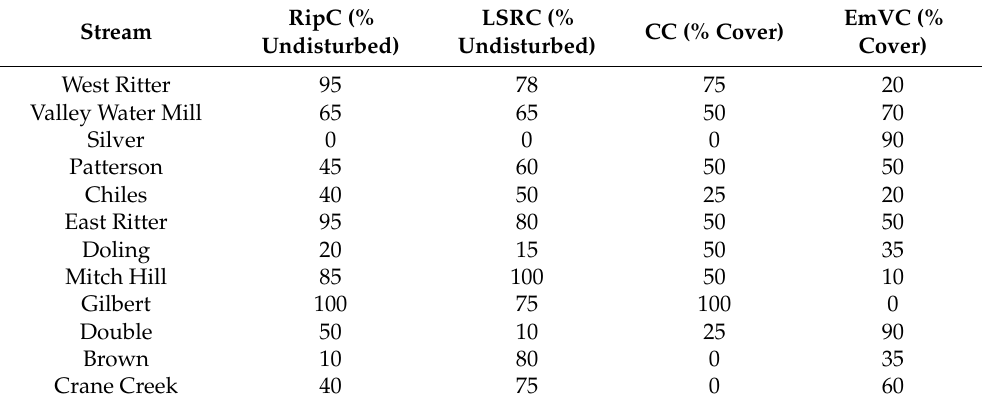
Table 4. Vegetation-associated variables used in ordination analyses. Variables listed here are local riparian conditions (RipC), landscape riparian conditions (LSRC), canopy cover (CC) and emergent vegetation cover (EmVC). All measurements are estimations made during summer sampling. RipC Stream